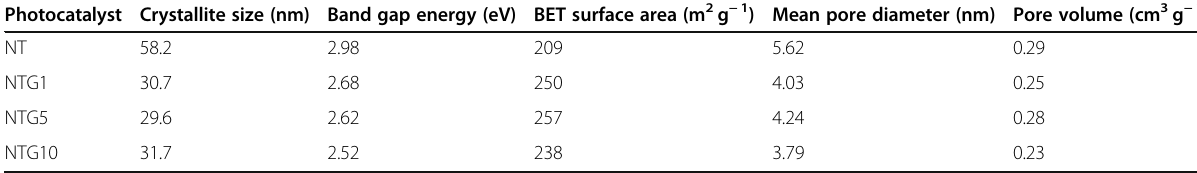
Fig. 2a. The formation of GO was confirmed by the appearance of the new peak at 2 θ = 12.68° with an interlayer distance of 0.699 nm corresponding to the (002) lattice plane [15].